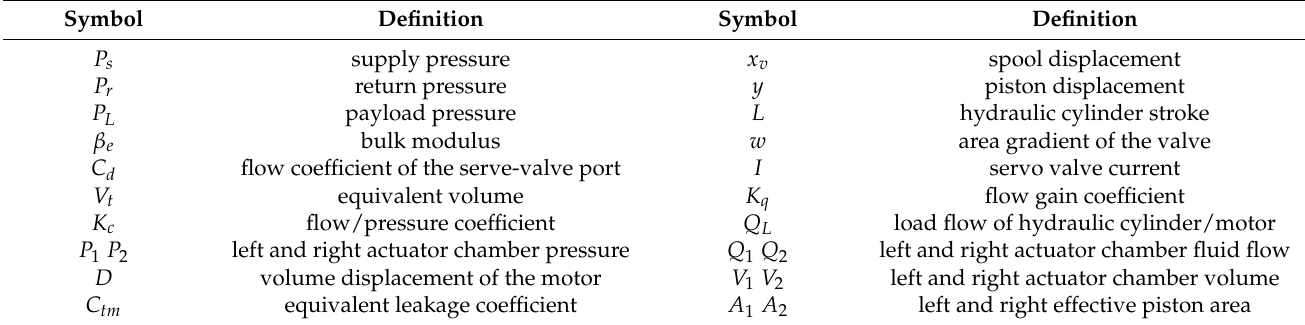
Table 2. Notation, frequently used symbols of hydraulic